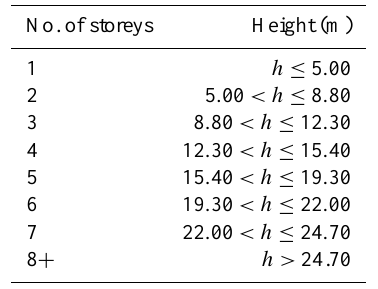
Table 1. Correspondence between height classes (census) and height intervals (building vector data).